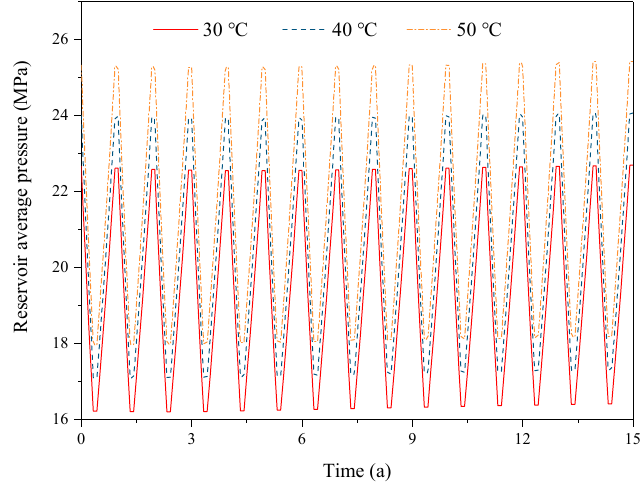
Figure 13. Reservoir average pressure for different temperature.